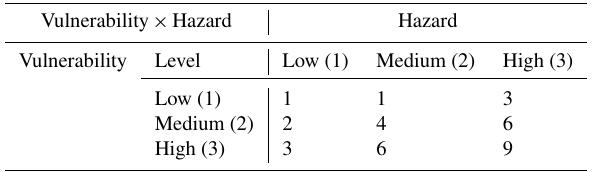
Table 4. Inundation by tsunami risk matrix for the town of Dichato. Vulnerability × Hazard